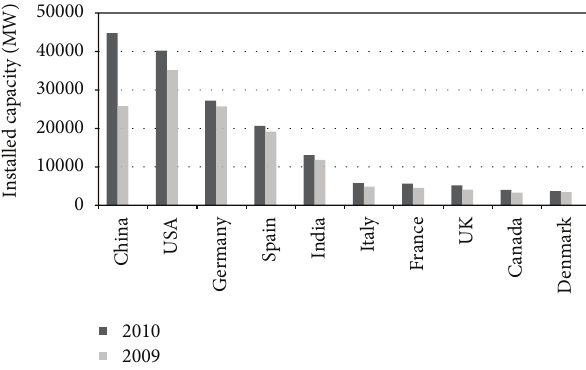
Figure 2: Top ten countries in terms of total installed wind power capacity in the